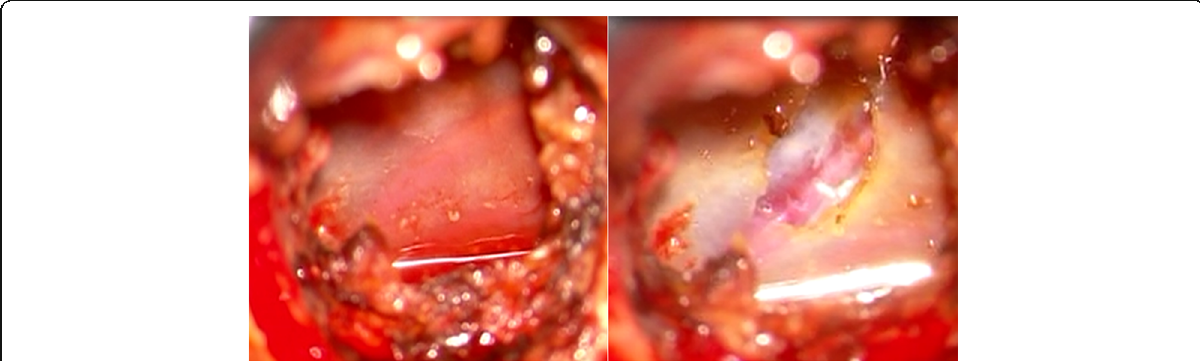
Fig. 1 Intraoperative photographs showing inner membrane before (left) and after (right)